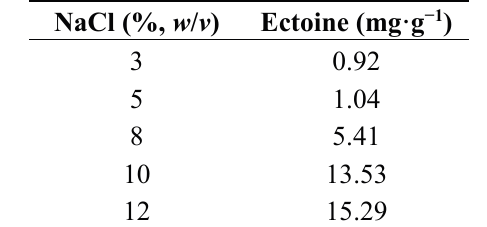
Table 1. Accumulation of ectoine in cells of Halomonas sp. strain 4-5 at different NaCl concentrations.